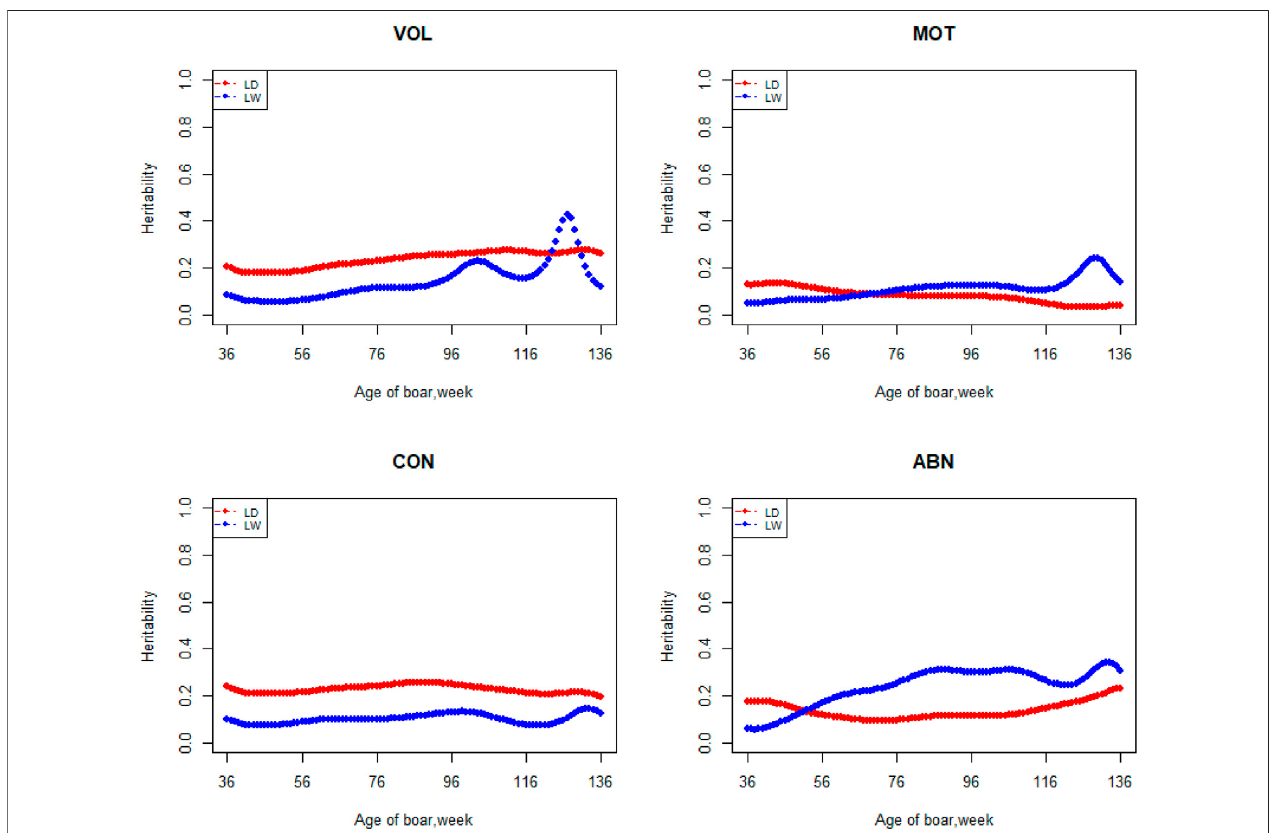
FIGURE 4 | Heritability from 36 weeks to the age of 136 weeks, estimated with a random regression animal model.